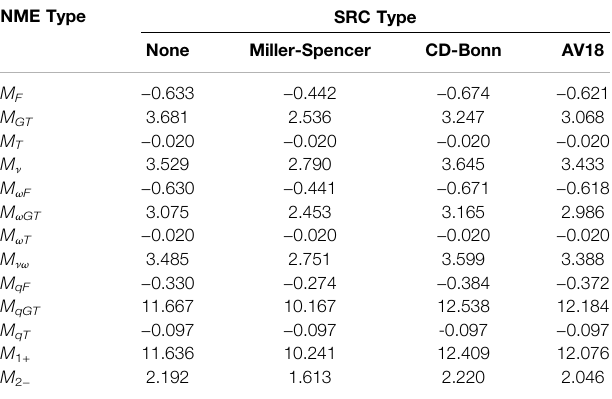
TABLE 2 | NMEs for 0 ] ββ (light neutrino-exchange and λ mechanism) of 82 Se.